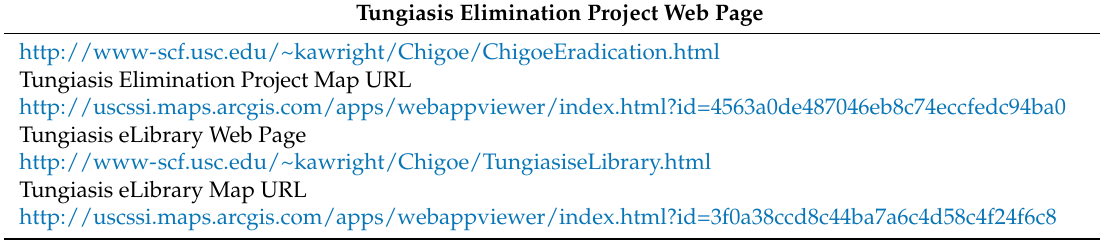
Table 1. URLs of the Tungiasis Elimination Project and eLibrary. Tungiasis Elimination Project Web